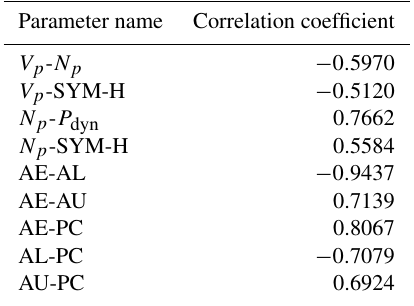
Table 4. The Pearson correlation coefficient of all 18 space physical parameters from December 1996 to March